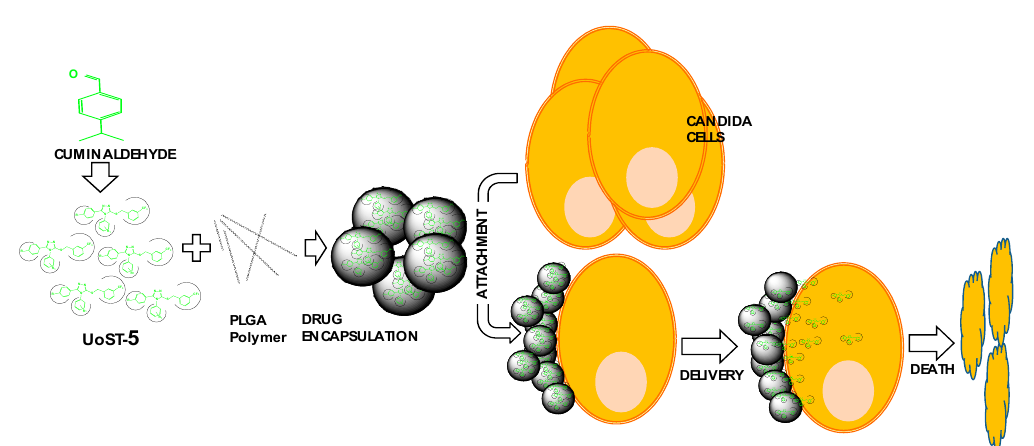
Figure 6. Graphical representation summarizes the synthesis, formulation and proposed mechanism of attachment and delivery of UoST5-NPs.